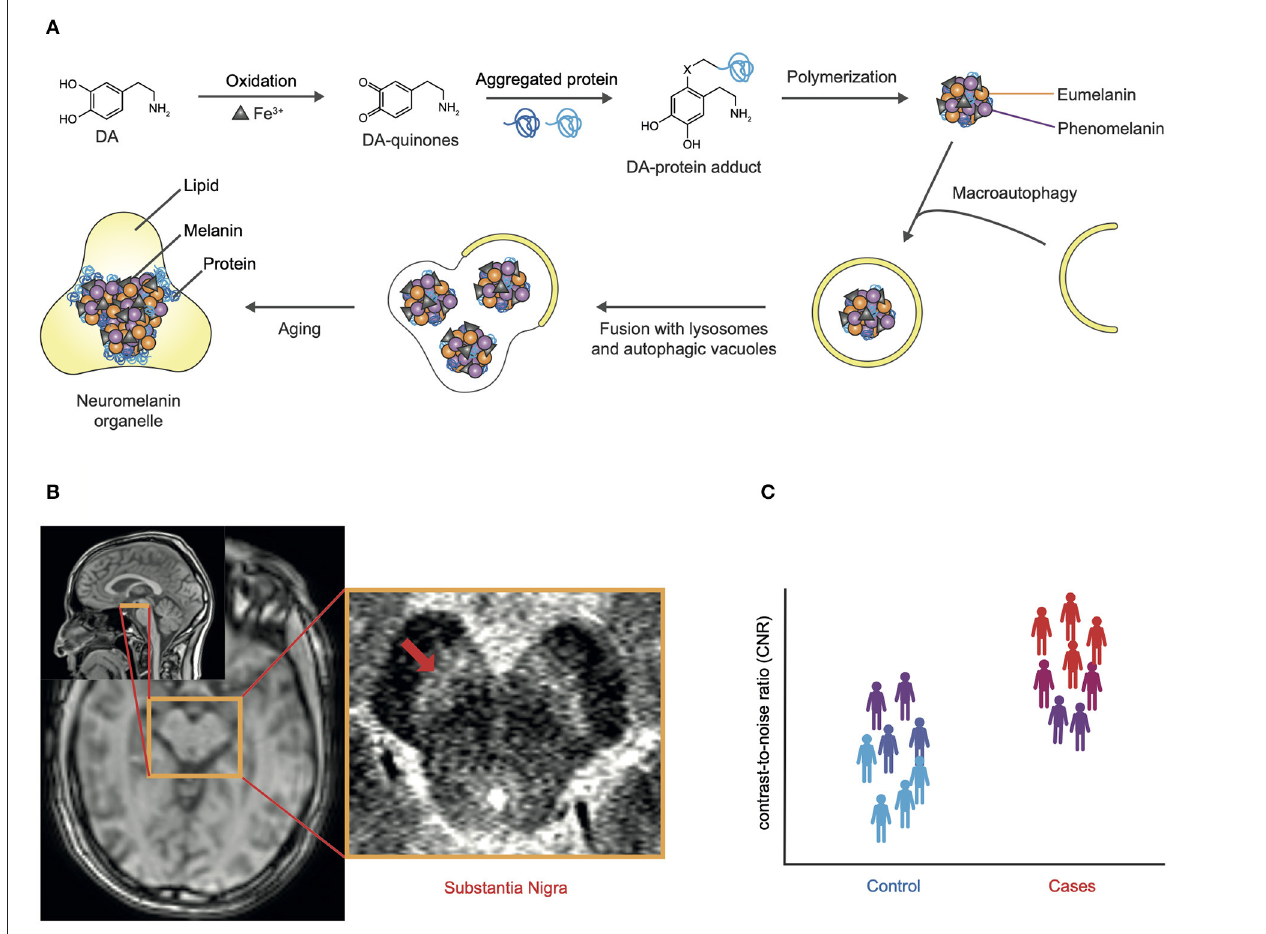
FIGURE 1 | (A) Hypothesized mechanisms of NM biosynthesis adapted from Sulzer et al. (11): Dopamine (DA) oxidates, advanced by ferric iron (Fe + 3 ). Oxidized DA-quinones react with cytosolic proteins and are polymerized, thereby initiating formation of a melanin-protein component with eumelanin and pheomelanin and resulting in an undegradable iron-melanin-protein complex. Macroautophagy is initiated and the complex is taken up into an autophagic vacuole. Fusion with lysosomes enables this vacuole to merge with other vacuoles, containing lipids and proteins and eventually result in neuromelanin organelles, that accumulate with increasing age of the organism. (B) NM-MRI of an exemplary slice lay-out (yellow) of the substantia nigra (SN) (red arrow) and its position within the brainstem on the left hand side localizer images. (C) Schematic scatter plot depicting contrast-to-noise ratio on the ordinate in controls (blue) and cases (red) with a dimensional biomarker approach